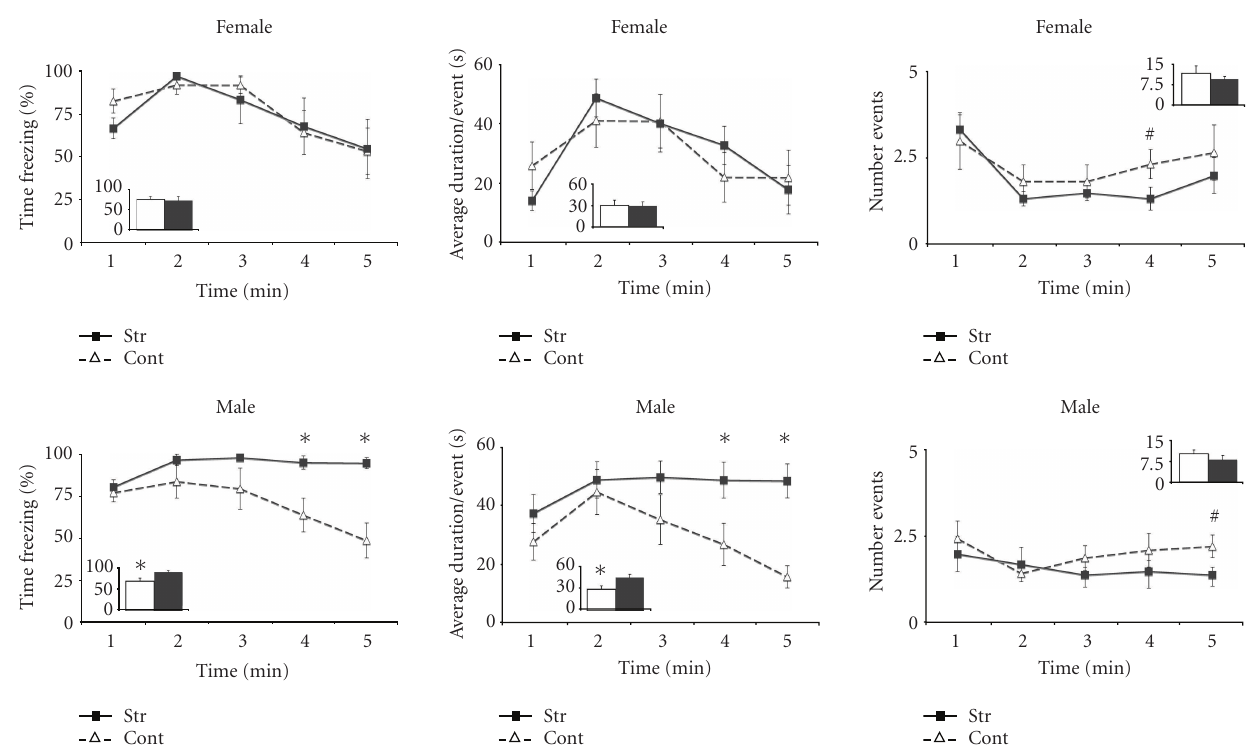
Figure 3: Auditory fear conditioning in adolescence. Mean percent freezing (left), duration of the average freezing event (middle), and number of freezing events (right) ( ± SEM) on successive 1minute blocks during reexposure to the conditioned tone in female (upper panel) and male (lower panel) rats that had been submitted to stress prior to the onset of puberty (filled squares) or control animals (open triangles). Within these figures, the total freezing value (percentage, average duration, or number) during the entire duration of the tone is represented as bars in the inserts. ∗ P < . 05, # P < . 05 < .